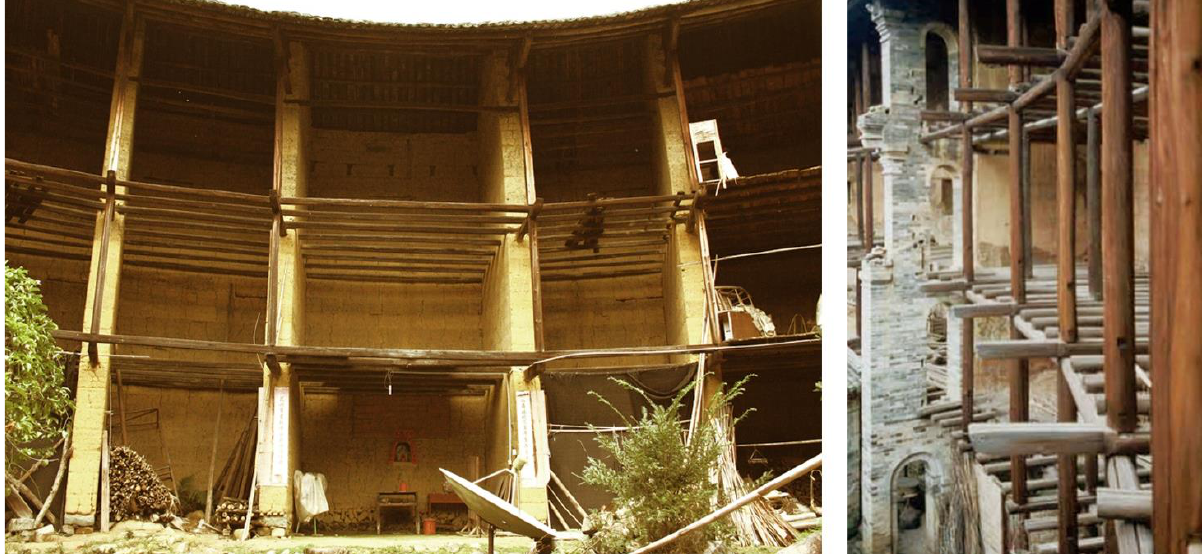
Figure 3. On the left, a Minnan Tulou with rammed earth load-bearing walls and wooden beams; on the right, a Hakka Tulou with wooden frameworks (2018, picture taken by E.